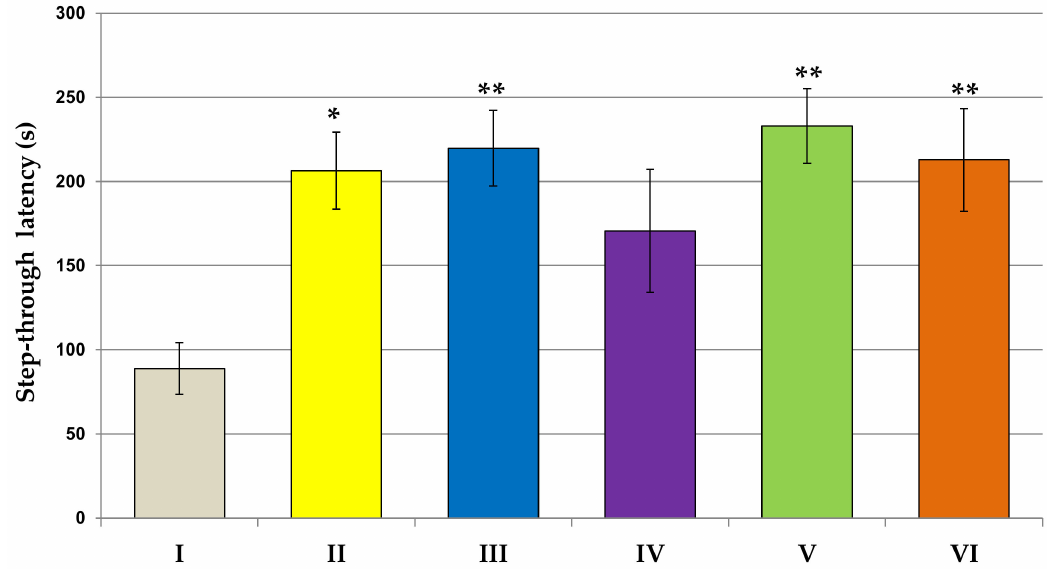
Figure 3. The influence of extracts on the learning and memory performance in passive avoidance test. All values are reported as mean ± SEM ( n = 7). Significance: * p < 0.05, ** p < 0.01 vs. control group (one-way ANOVA followed by Tukey’s post hoc test). I— aqua pro injectione ; II— Narcissus